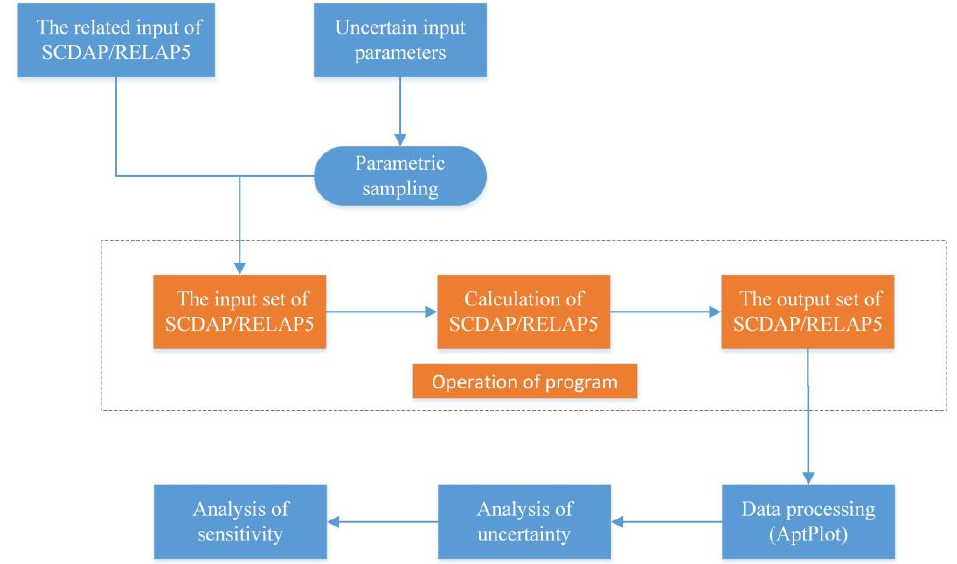
Figure 6. Flow chart of uncertainty analysis method.